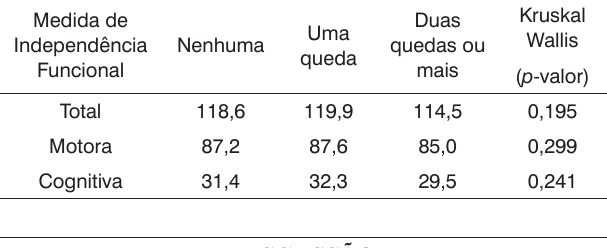
Tabela 3. Análise comparativa dos resultados médios da Me- dida de Independência Funcional (total, motora e